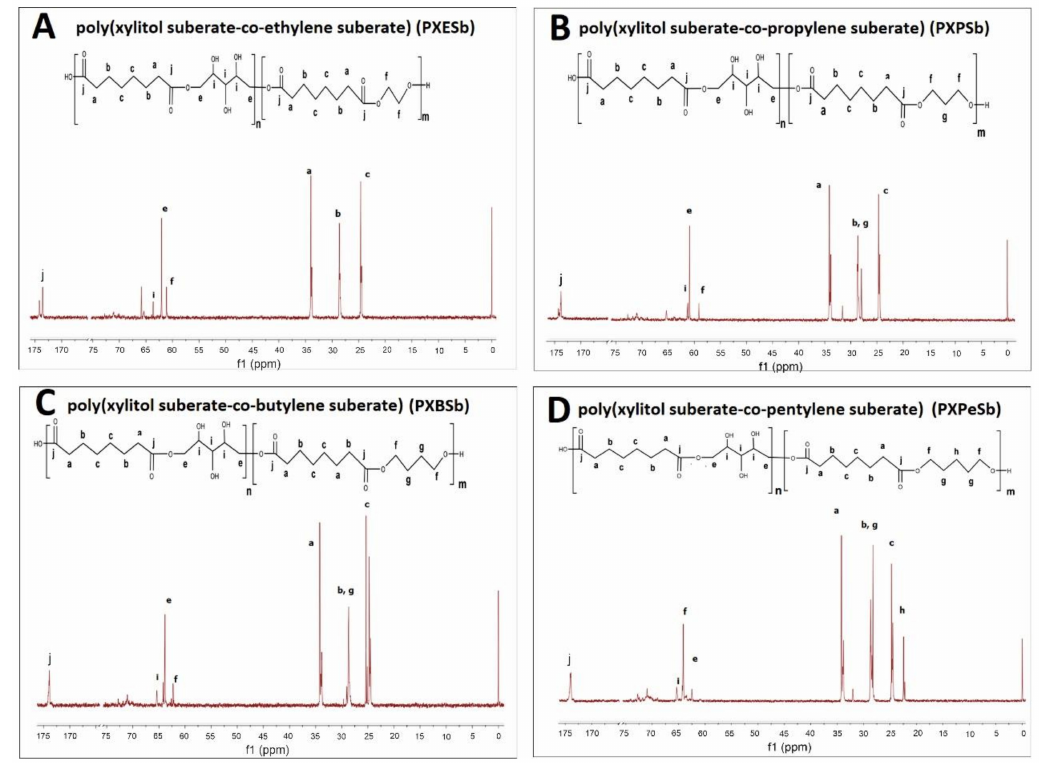
Figure 4. 13 C NMR of following prepolymers: PXESb ( A ), PXPSb ( B ), PXBSb ( C ) PXPeSb ( D ) prepolymers.